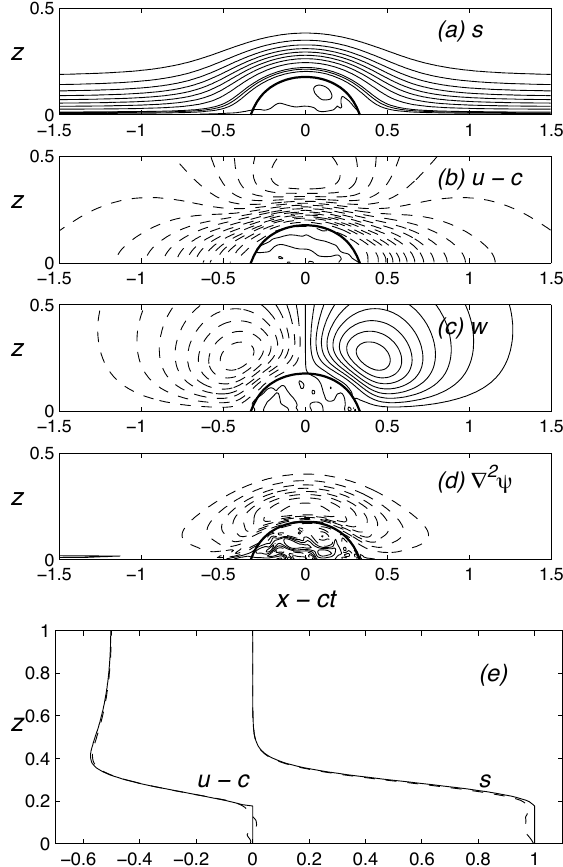
Fig. 10. Averages over t = 90 − 100 for the run in Fig. 9. (a) s , (b) u − c , (c) w , (d) ∇ 2 ψ . The s contour interval is 0.1 for s ≤ 0 . 9 and 0.025 for s > 0 . 9. The contour interval is 0.03, 0.015, and 0.5 for (b)–(d), respectively, with solid lines for values ≥ 0. (e) Vertical profiles of u − c and s at x − ct = 0 from the theory (solid) and numerical model (dashed). The heavy solid line in (a)–(d) shows the core boundary from stagnant-core DJL